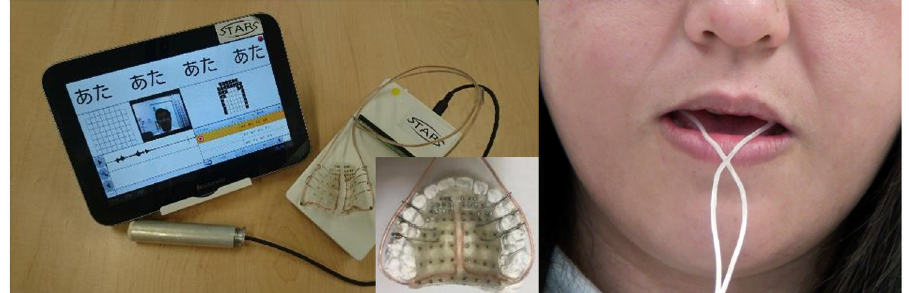
Fig 1. Instrumentation. A tablet-type EPG system and recording system (STARS), and a picture of a participant wearing EPG plate.